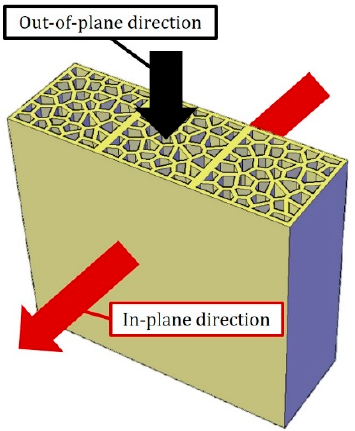
Figure 1. Schematics of a wall built by LCCCs, the in-plane direction is used for thermal insulation, and self-weight is generated at the out-of-plane direction. and self-weight is generated at the out-of-plane